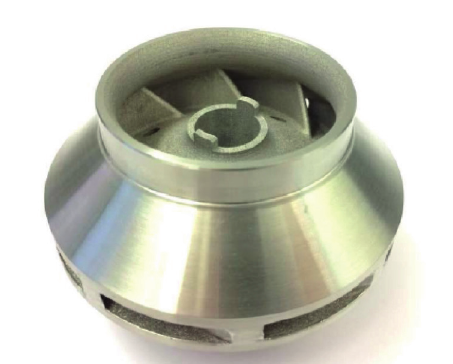
Figure 6. Printed and finalized experimental impeller, stretched and non-functional design, printed in one